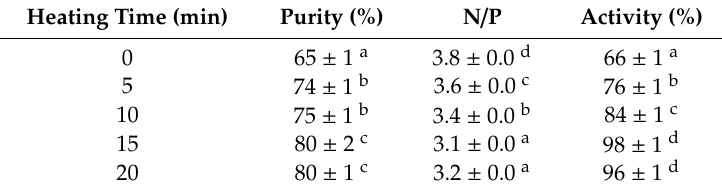
Table 2. Effect of ultrasound power (W) on purity, N/P and activity of Pv.